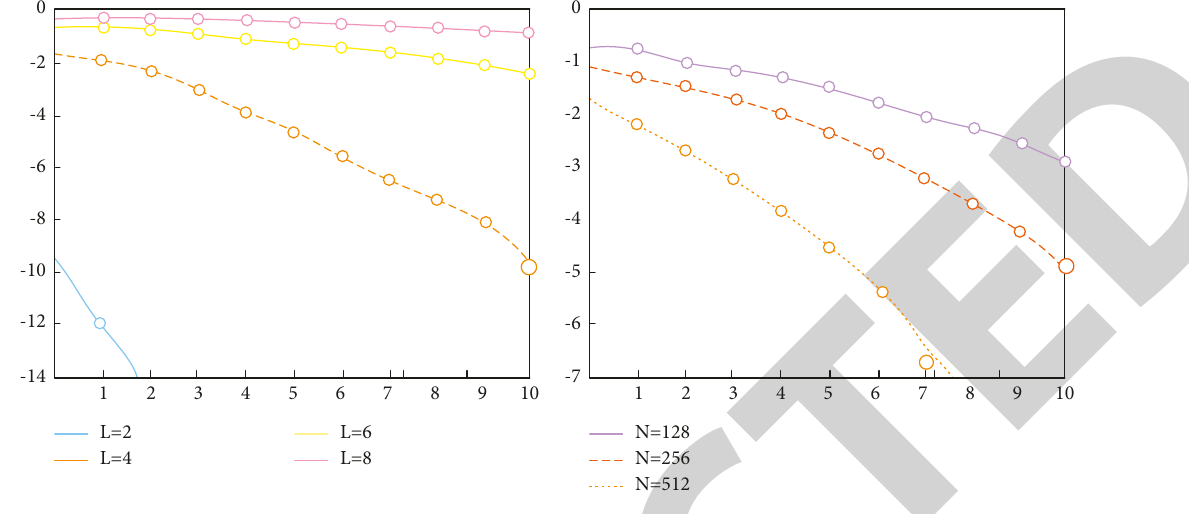
Figure 4: Average signal-to-noise ratio of transmitted signals.